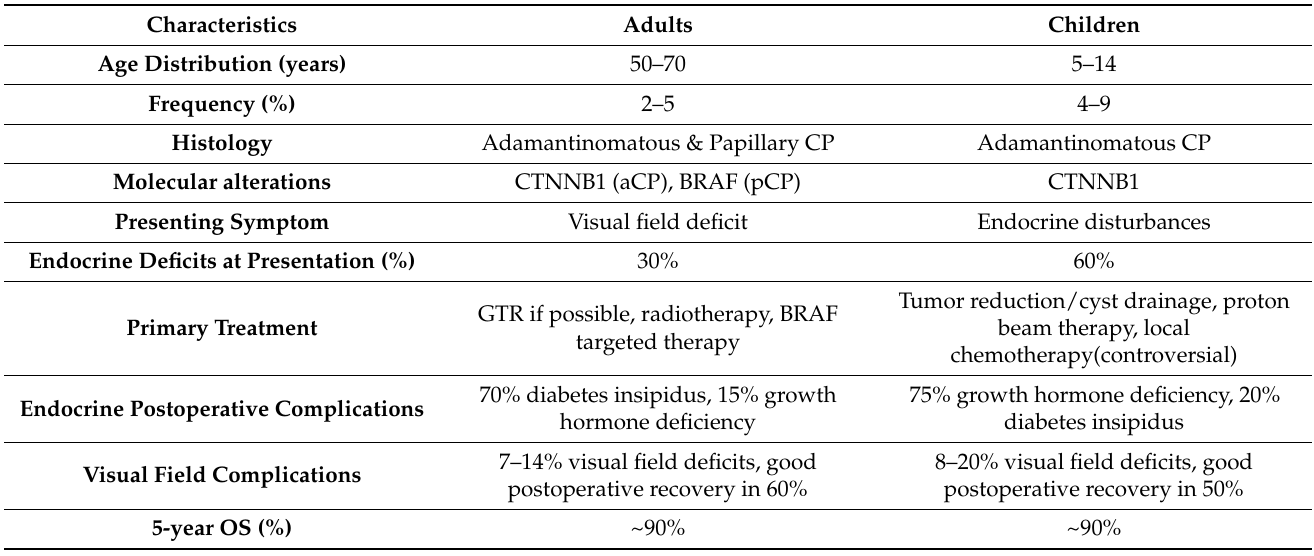
Table 4. Characteristics for adult and pediatric craniopharyngioma, based on data from the following references [76–81,83– 86,91,98,99,106–108] Abbreviations: CP = Craniopharyngioma, OS = overall survival.